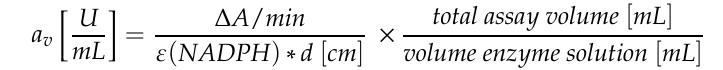
Supplementary Materials: The following are available online, Figure S1: Time-dependent inhibition of Tb TR by STLs 2 and 3 . Analogous plot to Figure